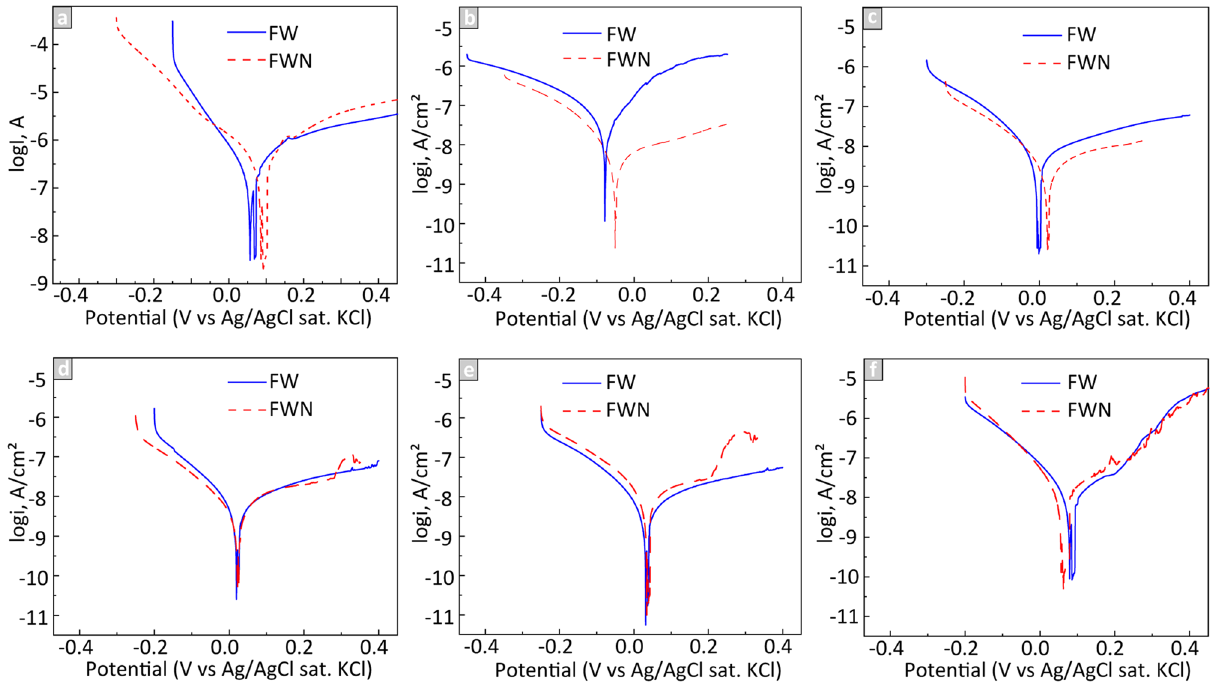
Figure 8. Typical potentiodynamic curves of the ( a ) PIGE, ( b ) Co, ( c ) Co 3 Ni, ( d ) CoNi, ( e ) CoNi 3, and ( f ) Ni NPs in synthetic freshwater with and without NOM (FWN,